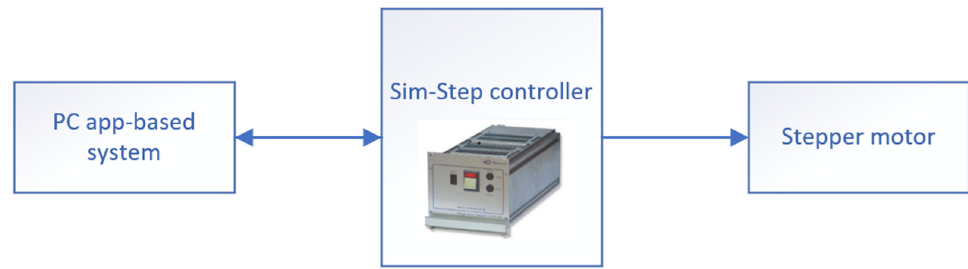
Figure 7. Angle controller connection.